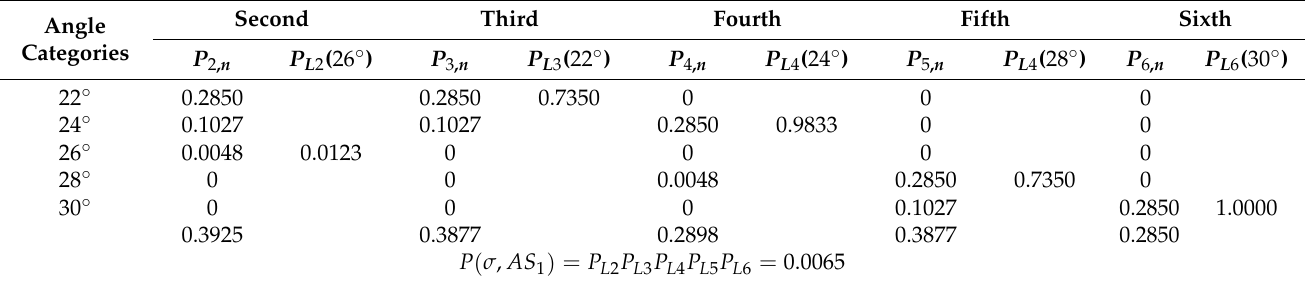
Table 1. An example of the method to calculate angle